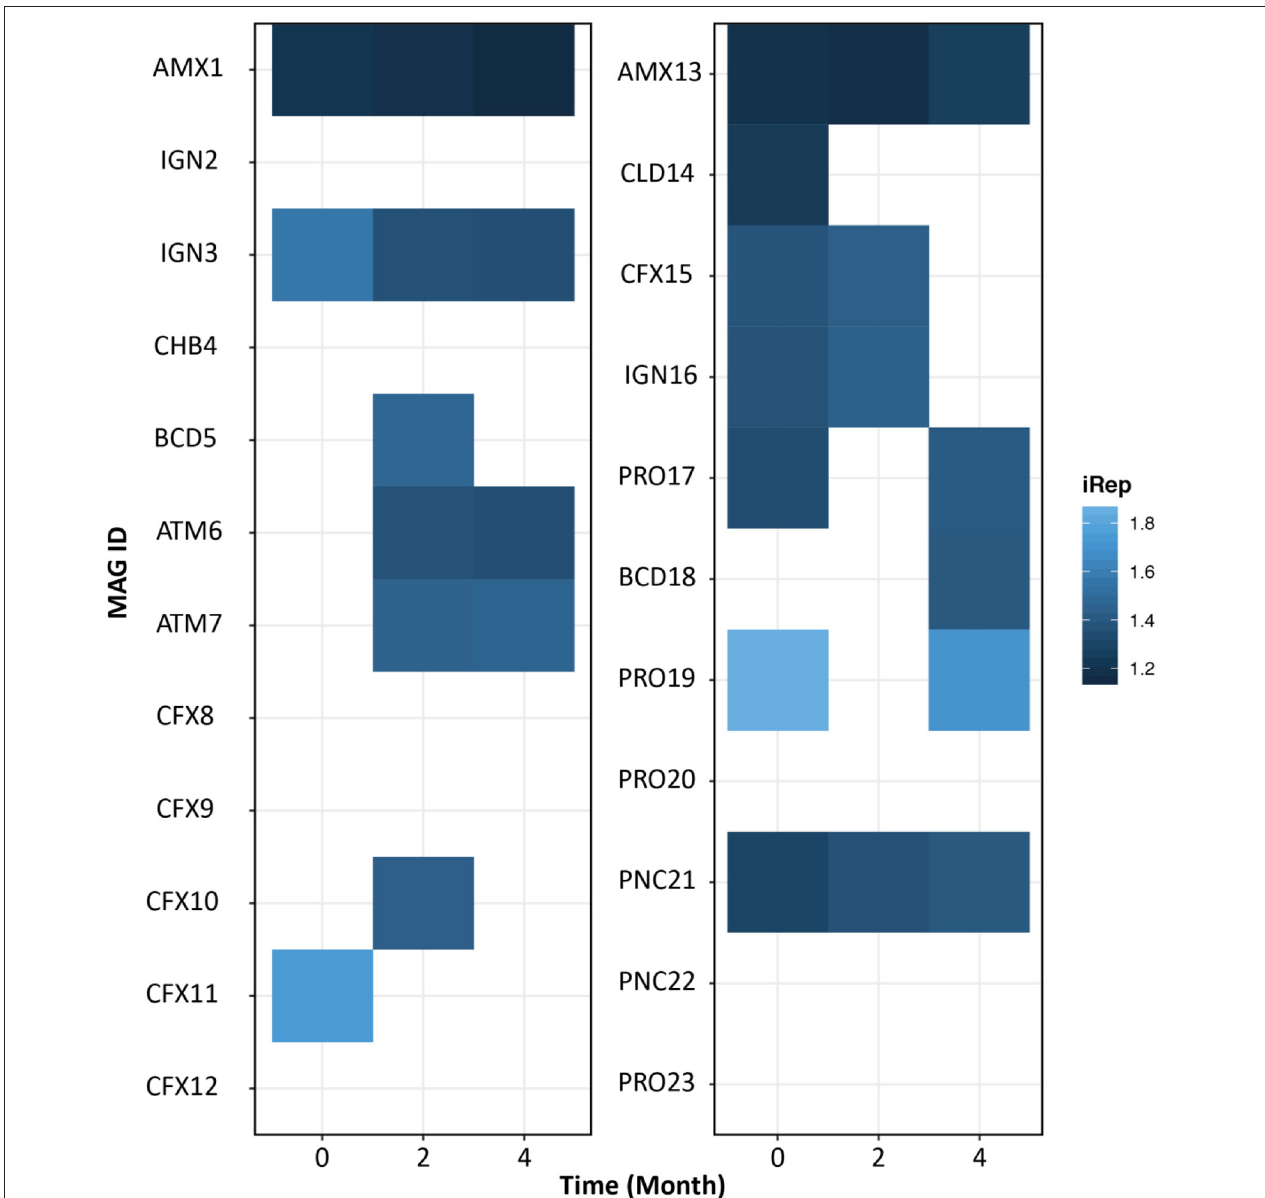
FIGURE 5 | Index of replication (iRep) reflecting bacterial growth rate for freshwater (left) and marine water (right) reactor. Gradient indicates the iRep values. iRep values were estimated for the MAGs with a minimum average coverage of 10 using default parameters. The empty (no-colored) squares represent genomes that did not meet the iRep measurement